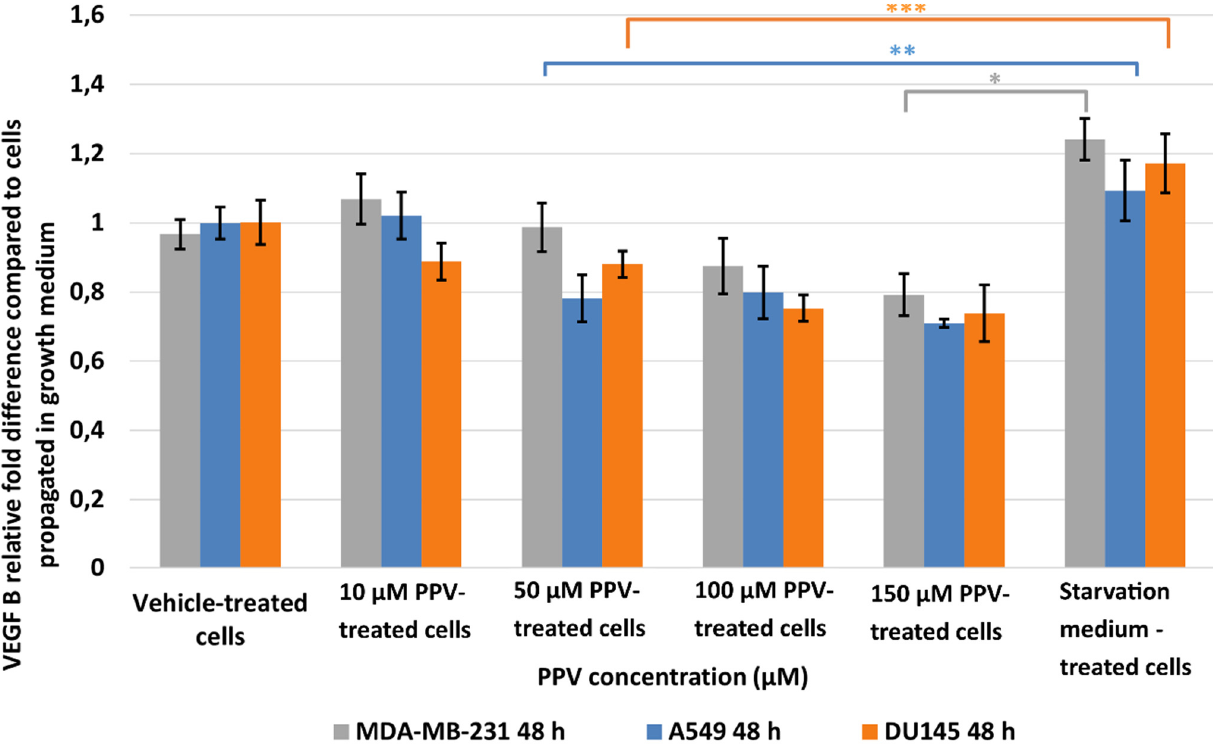
Figure 4. Spectrophotometry results of VEGF B ELISA demonstrating the effects of PPV (10–300 µ M) on proliferation on MDA-MB-231 cells compared to A549- and DU145 cell lines at 48 h. The average of three independent experiments is represented by the graph with error bars indicating standard deviation. The statistical significance of MDA-MB-231 cells is indicated with an asterisk (*), the statistical significance of A549 cells is indicated with two asterisks (**), and the statistical significance of DU145 cells is indicated with three asterisks (***). Statistical significance is represented by an * when using the student t -test with a p value of 0.05 compared to cells propagated in complete growth medium.